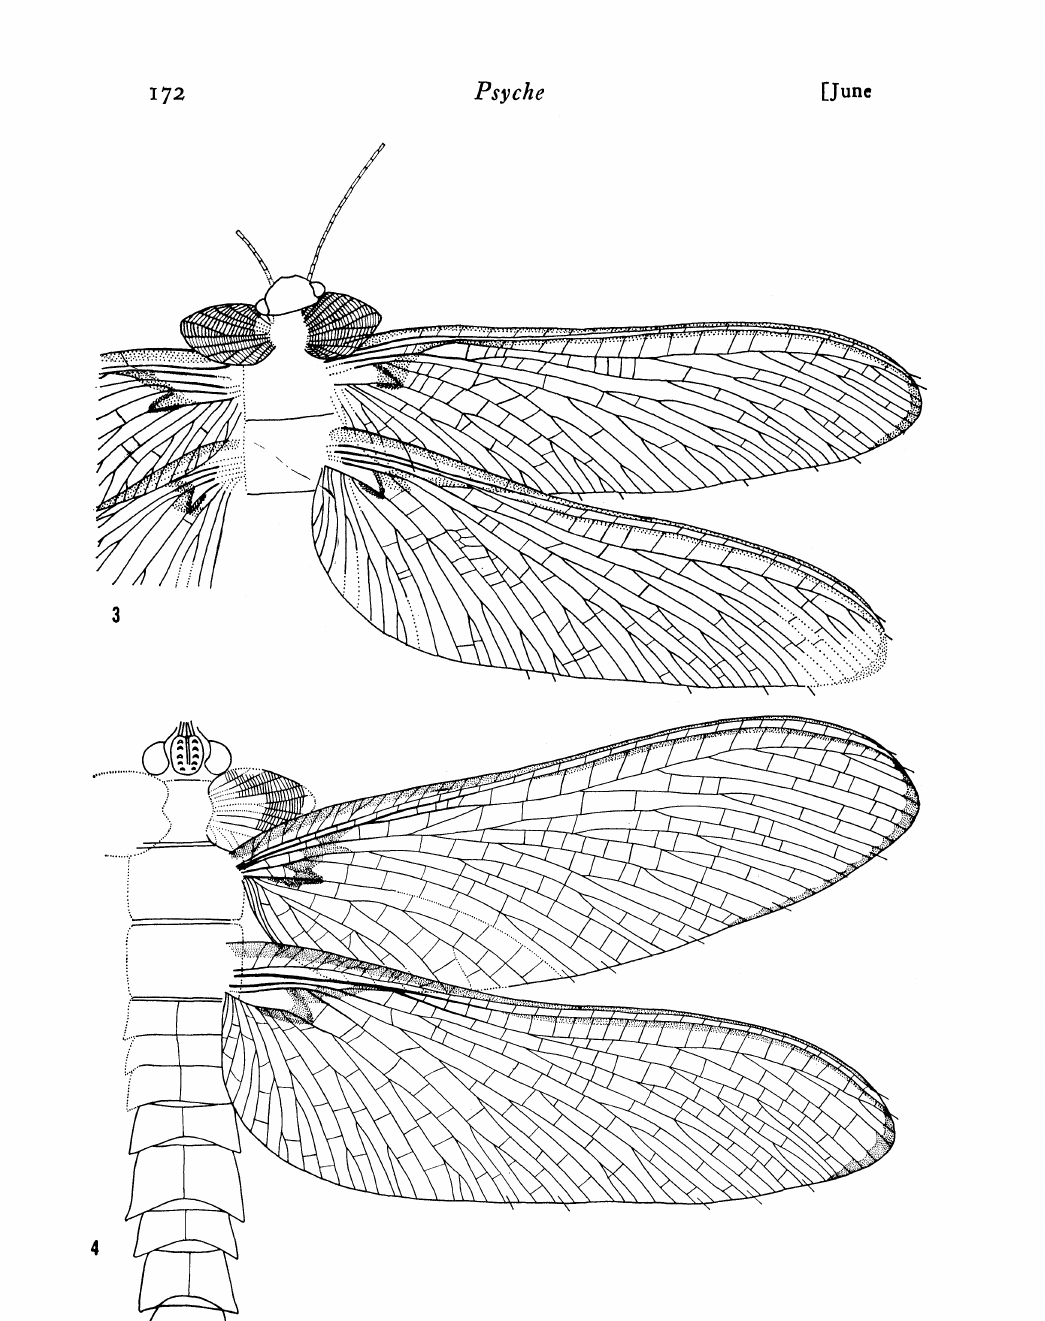
Figure 3. Homaloneura’ bonnieri Brongniart; specimen 17-17. Holotype. Figure 4. Homaloneura bonnieri Brongniart; "specimen